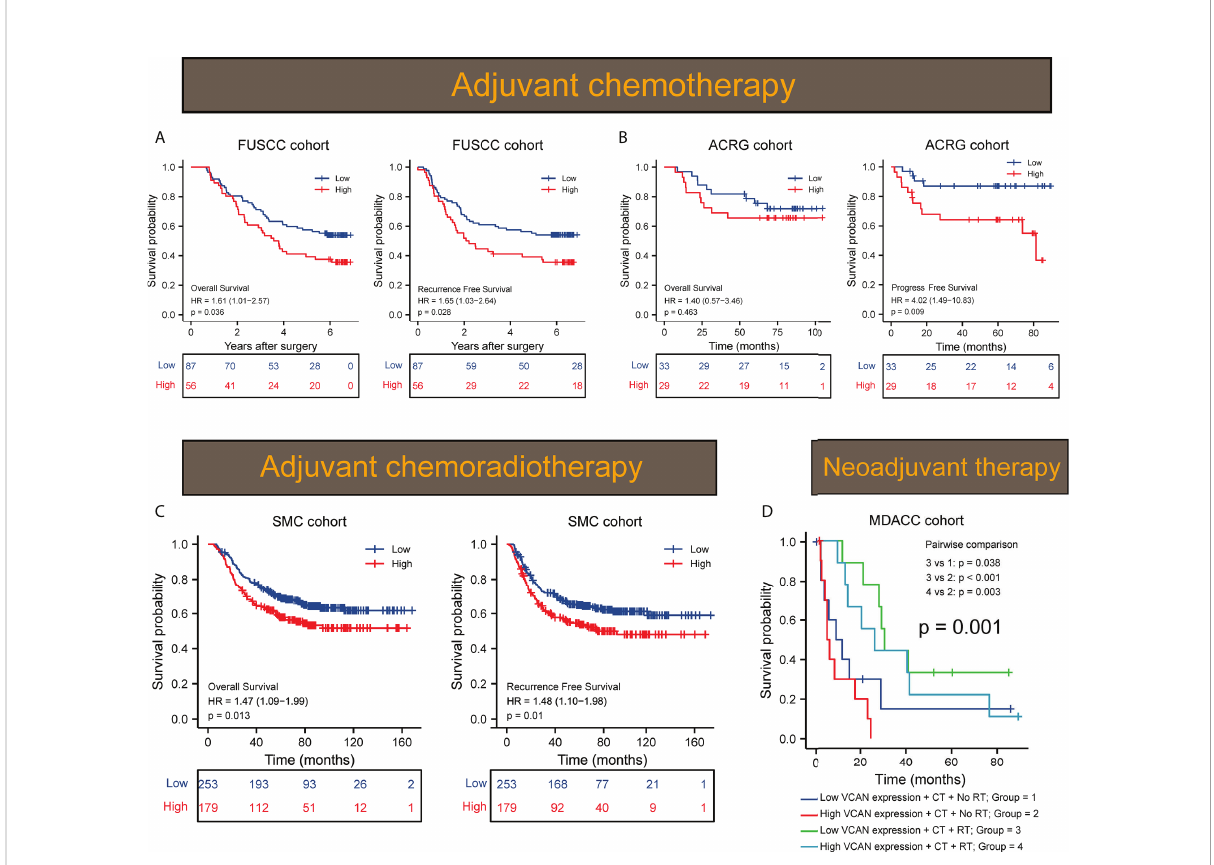
FIGURE 2 VCAN expression predicted response to adjuvant therapy in GC. (A) Kaplan – Meier curves of OS and RFS of low VCAN and high VCAN group in patients treated by ACT (n = 143) in FUSCC cohort. (B) Kaplan – Meier curves of OS and PFS of low VCAN and high VCAN group in patients treated by ACT (n = 62) in ACRG cohort. (C) Kaplan – Meier curves of OS and RFS of low VCAN and high VCAN group in patients treated by adjuvant chemoradiotherapy (SMC cohort, n = 432). (D) Kaplan – Meier curves of OS of low VCAN and high VCAN group in patients treated by neoadjuvant chemotherapy or chemoradiotherapy (MDACC cohort, n = 40). CT, chemotherapy; RT,